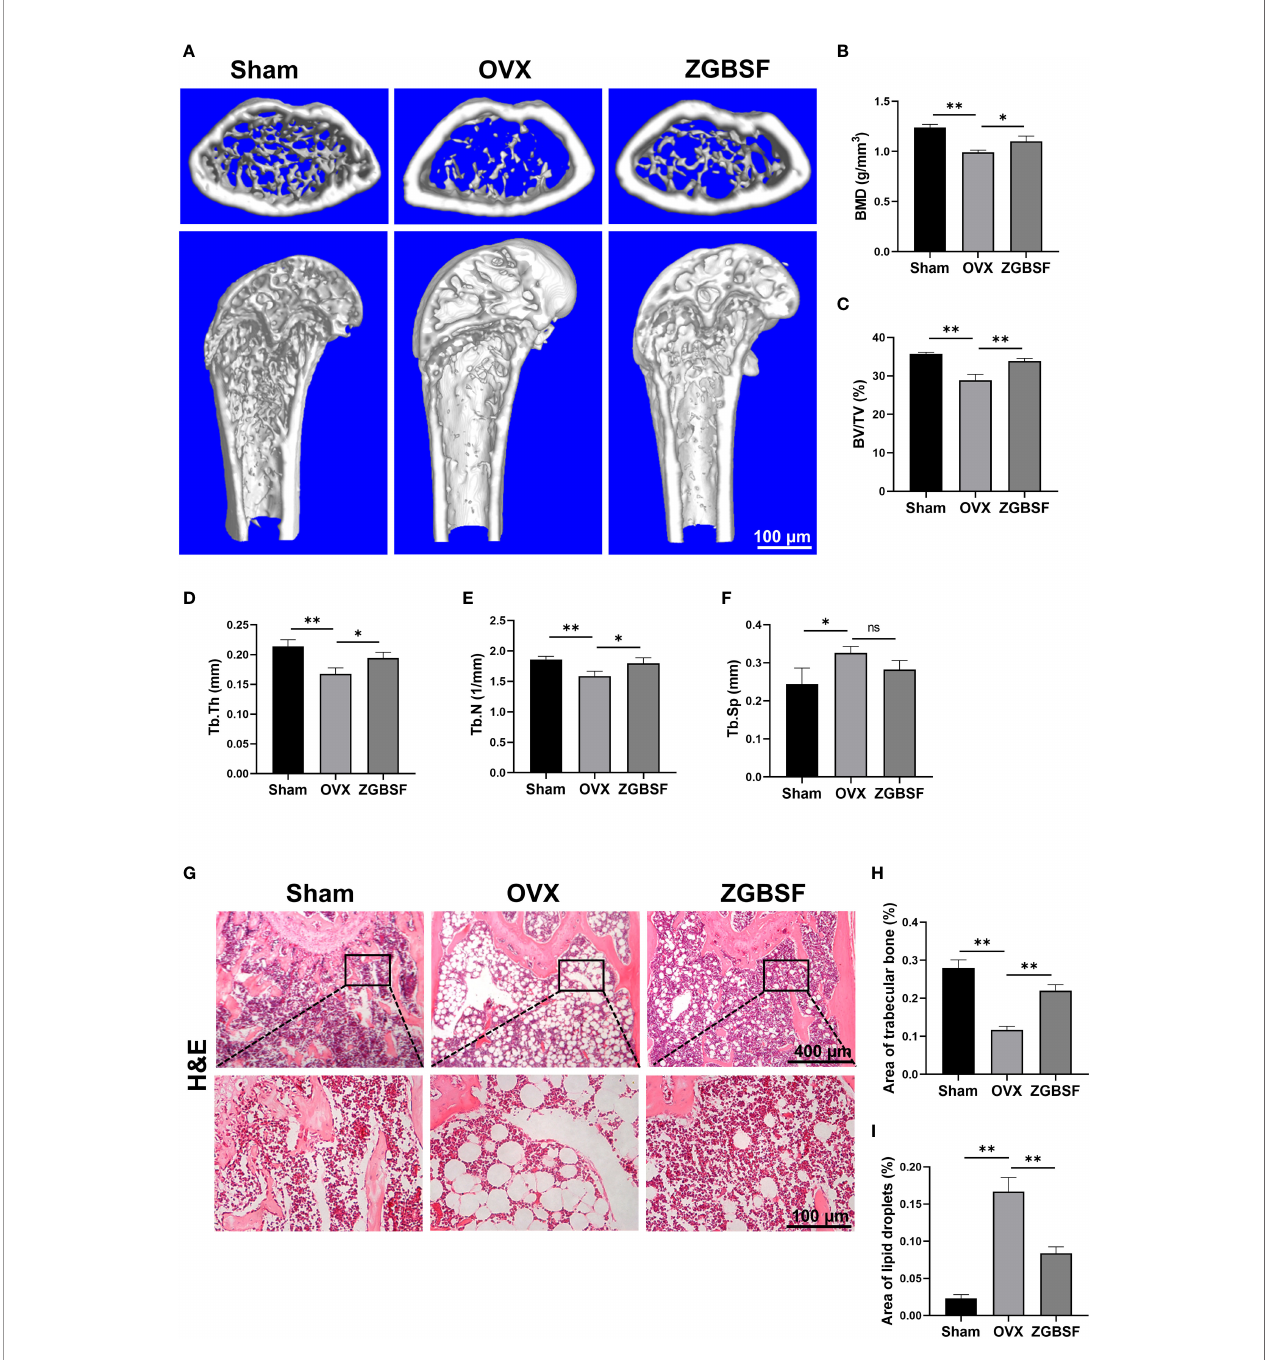
FIGURE 4 | ZGBSF ameliorates bone loss in OVX mice. (A) Representative m CT images of distal femoral. Quanti fi cation of bone mineral density (BMD) (B) , bone volume fraction (BV/TV) (C) , trabecular thickness (Tb.Th) (D) , trabecular number (Tb.N) (E) and trabecular separation (Tb.Sp) (F) . (G) Hematoxylin-eosin staining of the distal femur. (H) The area of trabecular bone (%). (I) The area of lipid droplets (%). Data were presented as mean ± SEM of three independent experiments. * P < 0.05, ** P < 0.01, NS indicated no signi fi cant